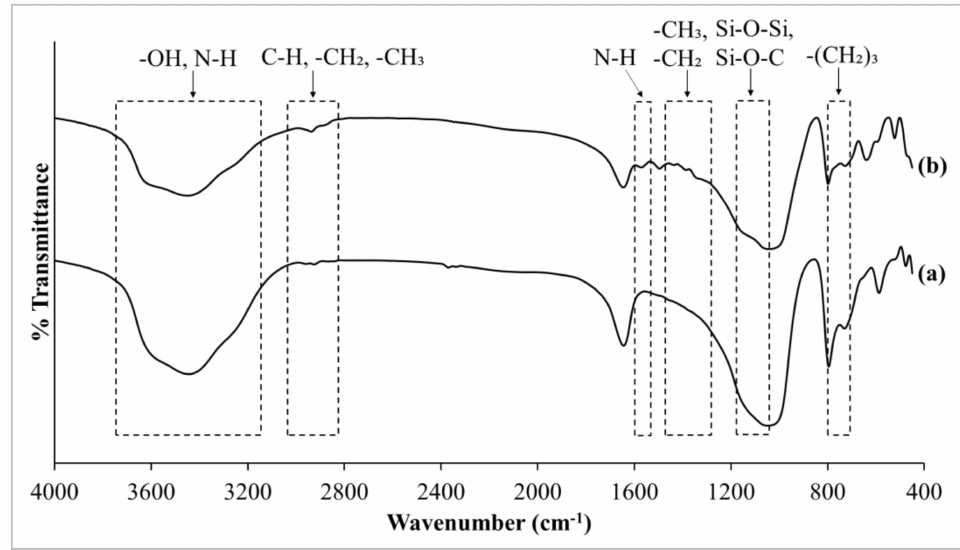
Figure 5. FTIR spectra of (a) zeolite RHO and (b) zeolite NH 2